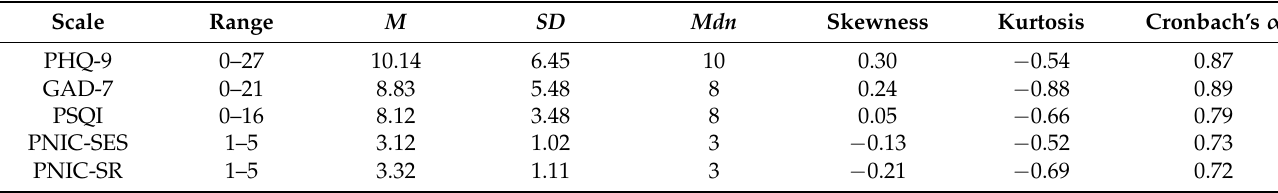
Table 4. Descriptive statistics for study